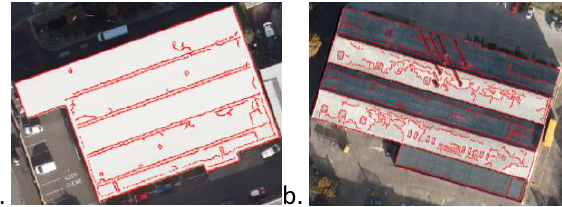
Figure 4. Edge detection results (red) from a. Flat 2 building and b. M-Shaped building overlaid onto